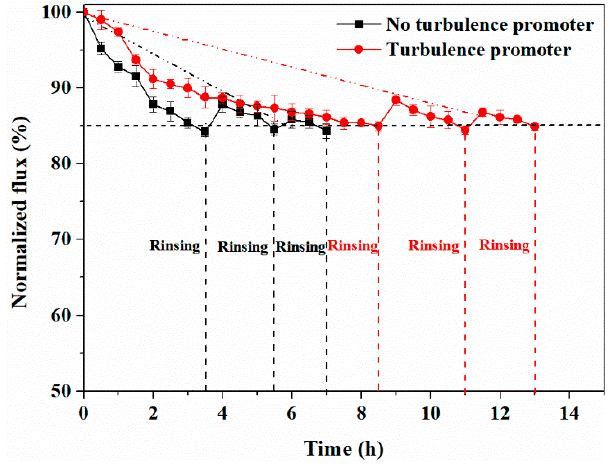
Figure 13. Variations of normalized flux with time (SSTS: 500 ppm HA, pH = 4; TMP = 0.5 MPa).